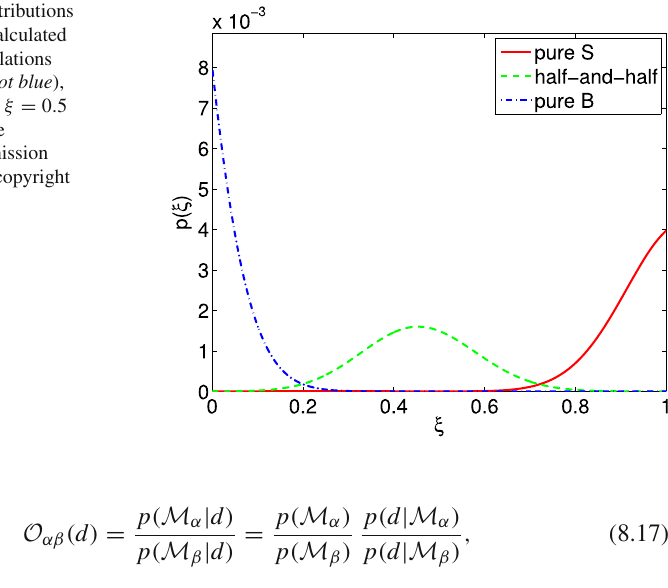
Fig. 59 Posterior distributions for the duty cycle ξ calculated for Monte Carlo simulations having ξ = 0 ( dash-dot blue ), ξ = 1 ( solid red ), and ξ = 0 . 5 ( dashed green ). Image reproduced with permission from Thrane (2013), copyright by